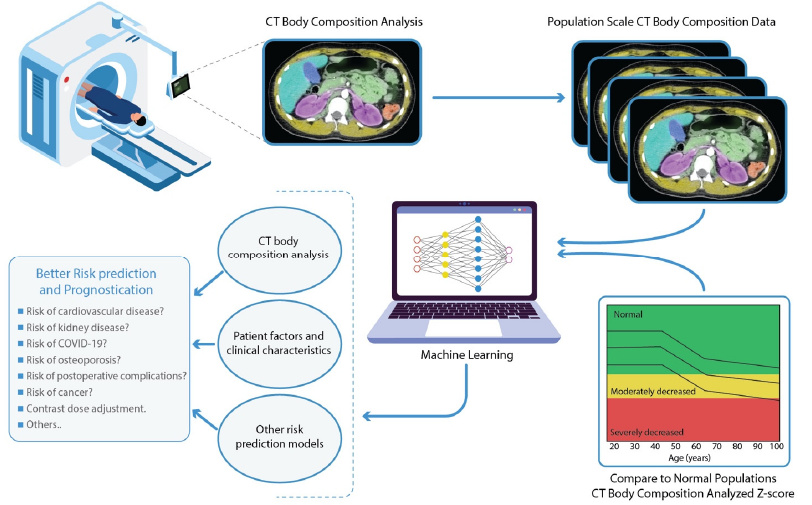
Figure 1. Population-scale machine learning-based CT body composition analysis for better risk prediction and prognostication. Body composition metrics can be extracted automatically from abdominal CT scans using machine learning-based segmentation approaches. Population scale CT body composition analysis can help establish age-, sex-, and race-specific Z-scores and reference curves for each metric. Patient-specific CT body composition metrics can be adjusted based on the reference curves prior to incorporation into risk prediction or prognostication models to aid in improved clinical decision-making.